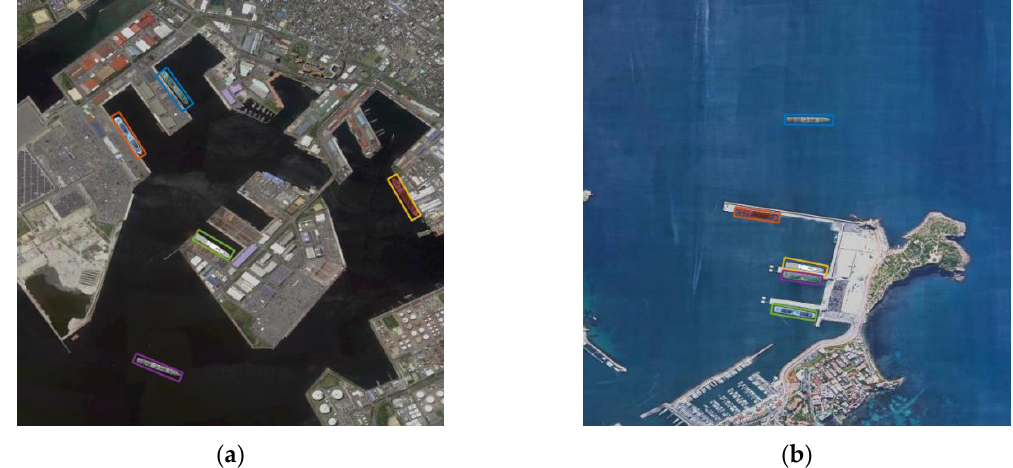
Figure 6. ( a , b ) are part of the simulated image set with annotations.